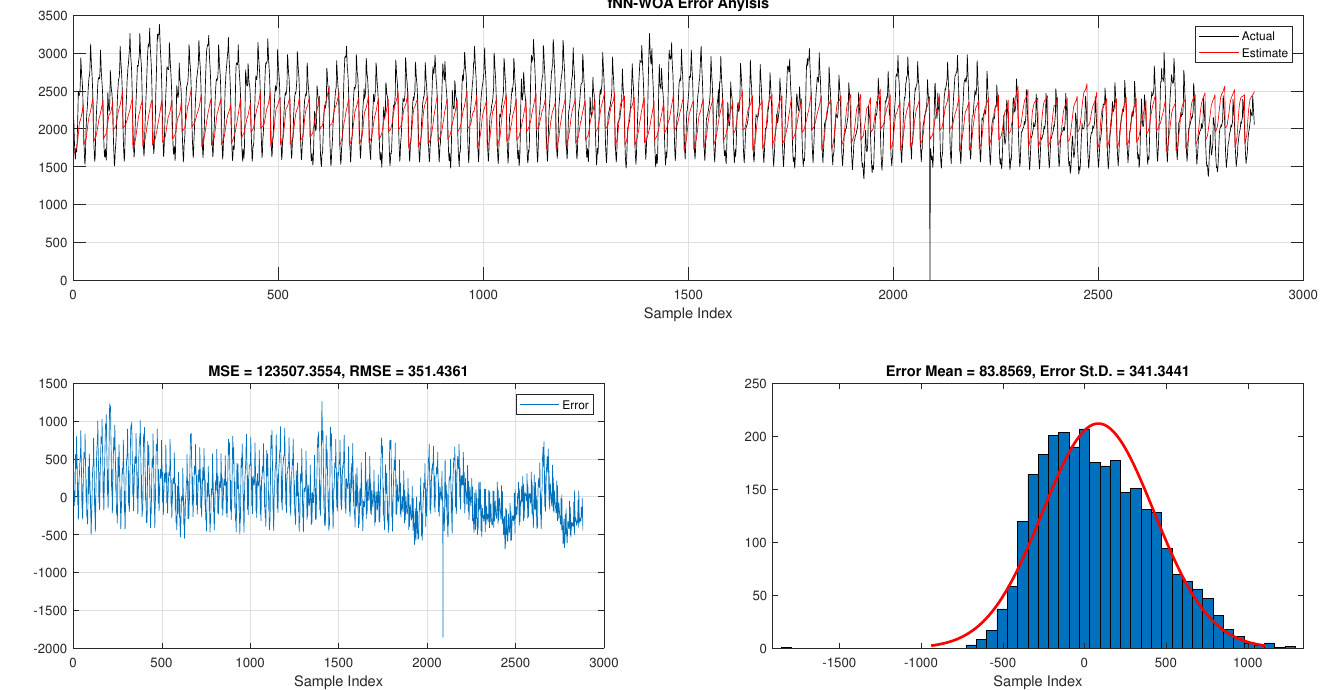
Figure 13. Error analysis of the hourly daily load consumption with fNN-ES best results.